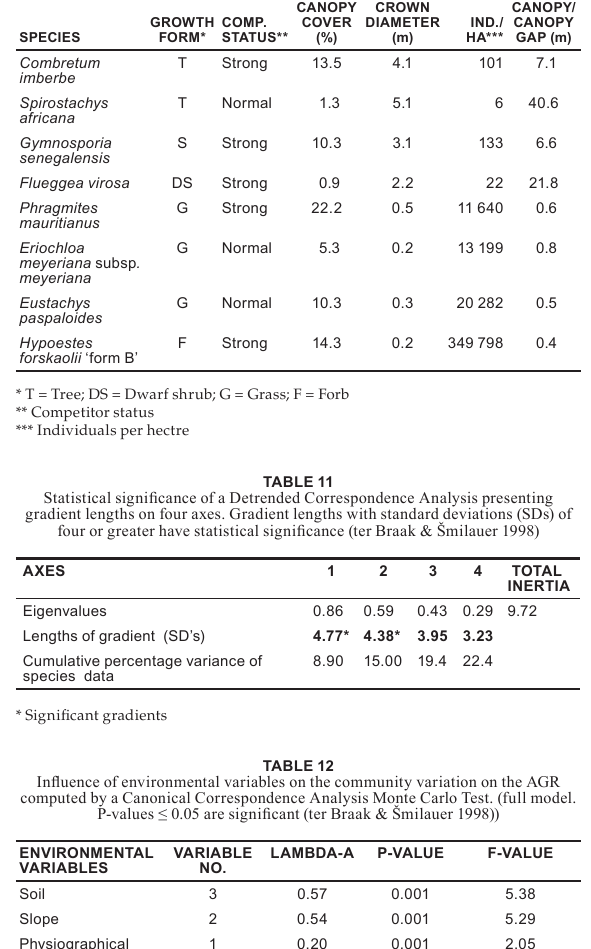
table 8 Species and growth form relations in Variant 2a